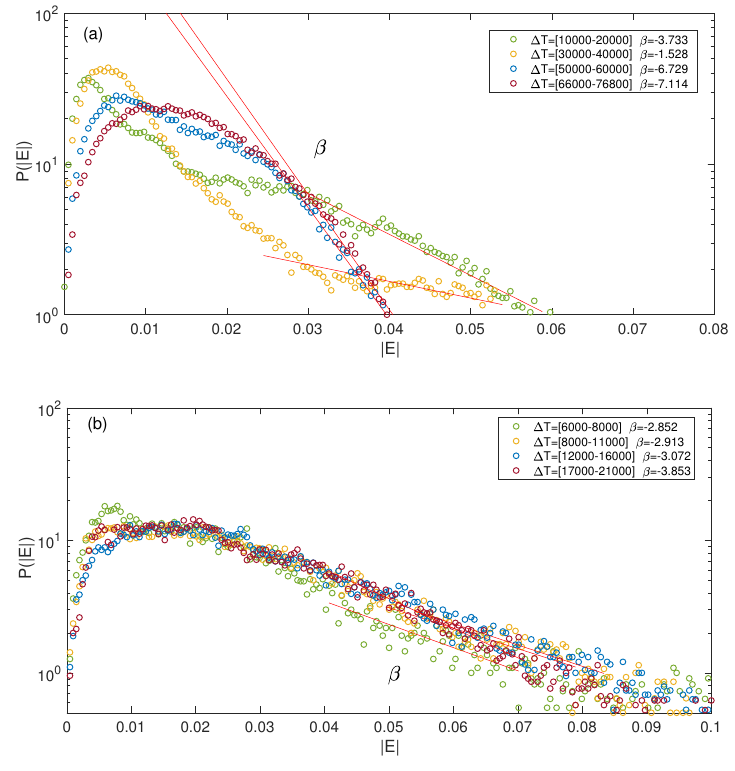
Figure 25. ( a , b ) Probability distributions of the electric fields’ amplitudes for different time intervals ∆ T , as indicated in the inserts with the corresponding interpolation parameters β ; the straight lines represent the linear fits at large | E | . The average level of fluctuations is ( a ) ∆ n = 0.01 ( b ) ∆ n =